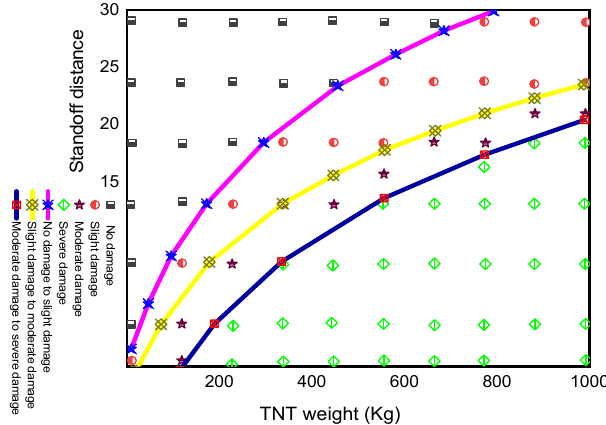
Figure 25. Prediction curve of the degree of dam damage.